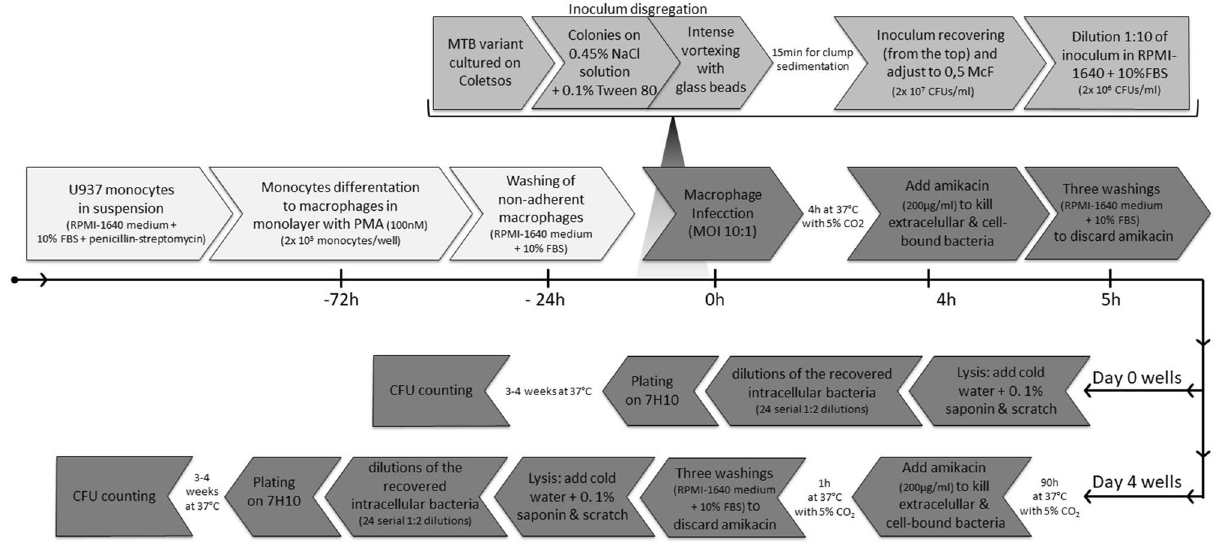
Figure 1. Flow chart indicating the steps in the infection